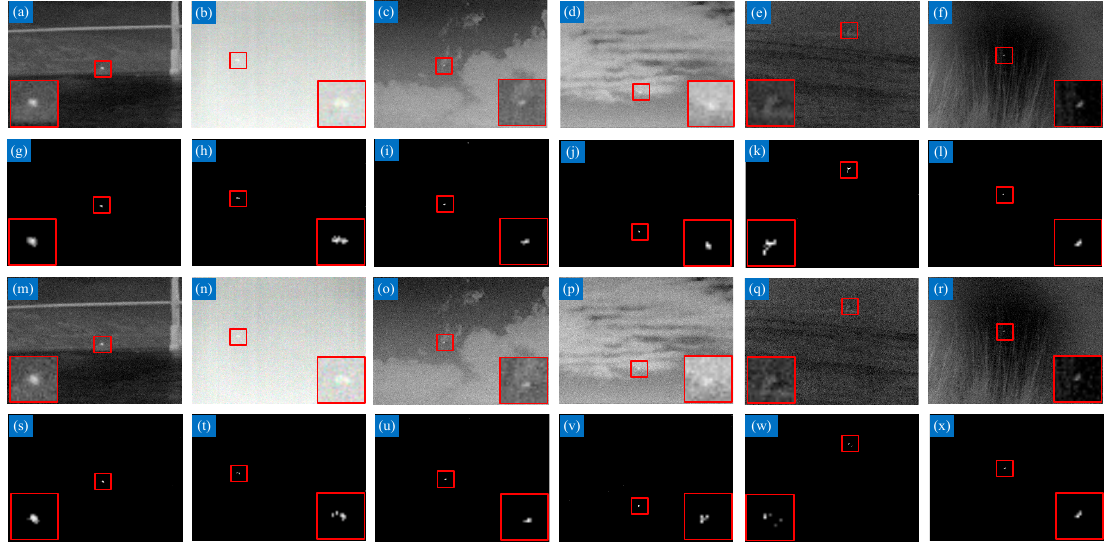
Figure 13. The first and third row are infrared images with additive white Gaussian noise with standard deviations of 10 and 20, and the second and fourth rows are the corresponding detection results by the proposed method.